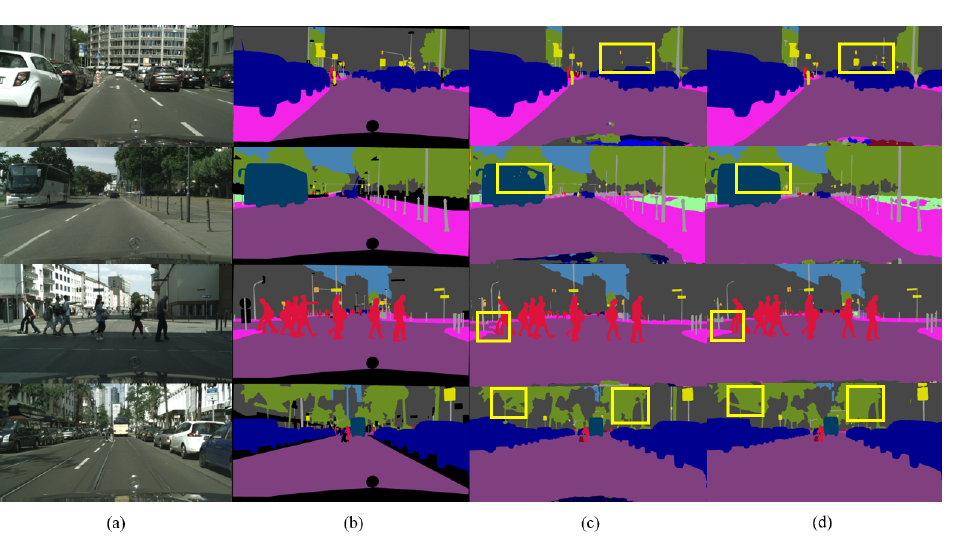
Figure 8. Comparisons between results of our work and results of baseline. The yellow rectangles mark the difference in segmentation accuracy between our method and baseline. ( a ) Denotes input images, ( b ) denotes ground truth, ( c ) denotes baseline, and ( d ) denotes our